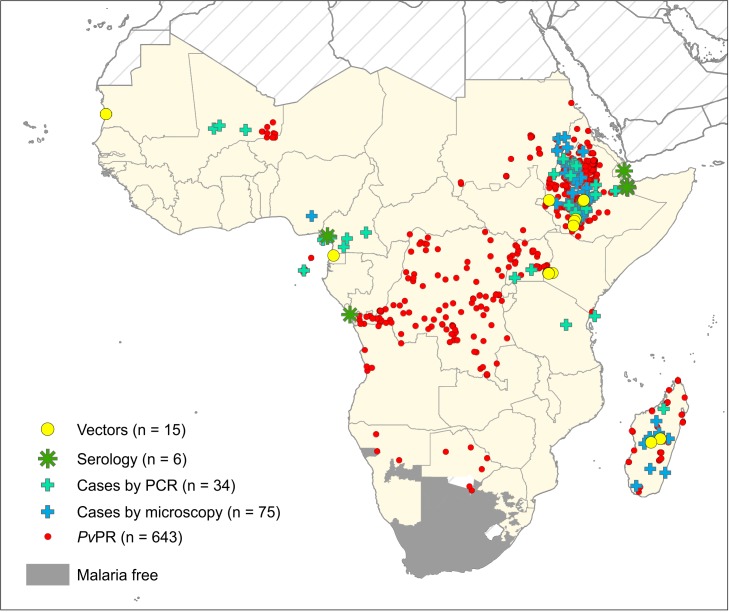
The evidence base of Pv occurrence in sub-Saharan Africa.All points represent a positive diagnosis of Pv. See S1–S3 Tables for original data.